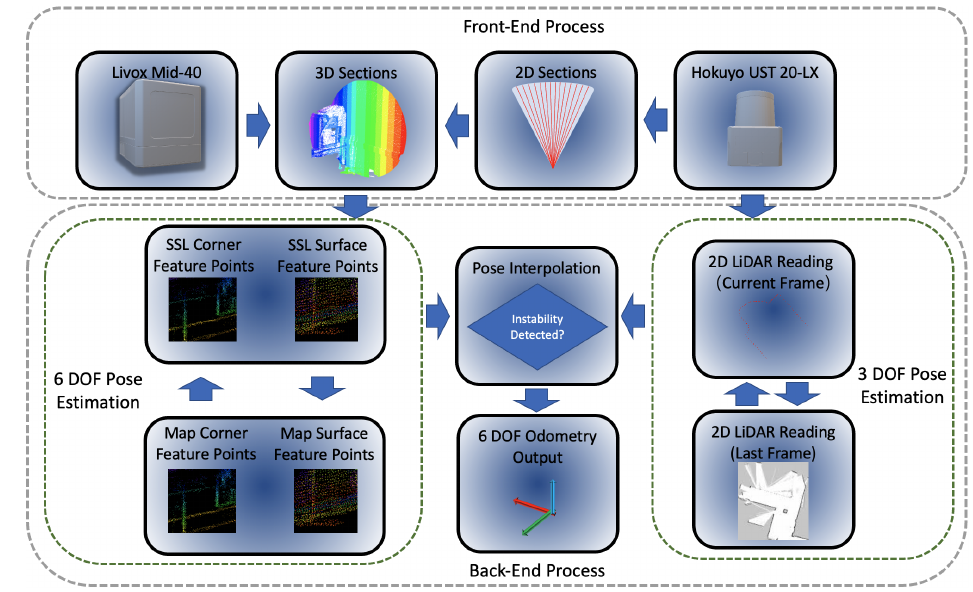
Figure 6. Data flow of the proposed dual-LiDAR odometry